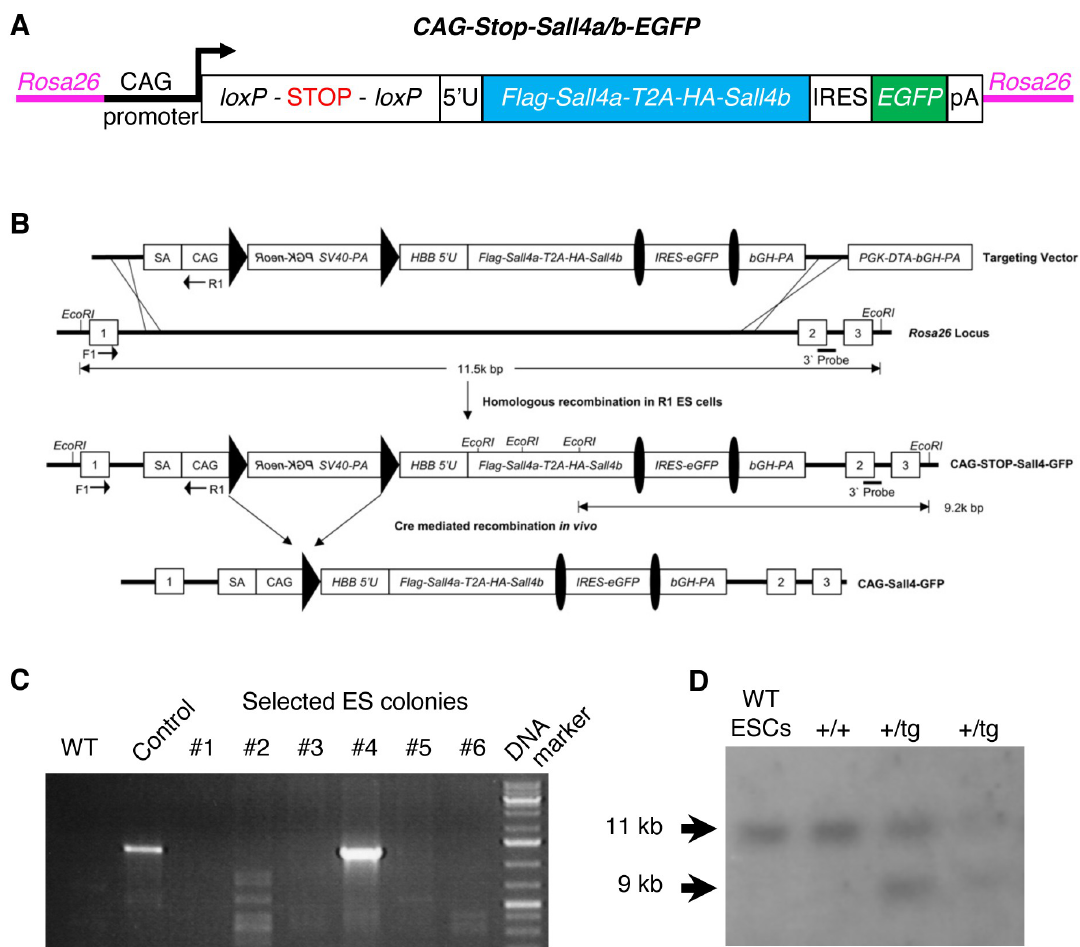
Fig 1. Sall4 conditional expression transgene. (A) Targeting vector used to insert the conditional expression construct for Sall4 into the Rosa26 locus in ES cells. (B) Schematic of the targeting strategy. The targeting vector also contains a diphtheria toxin negative selection cassette ( PGK-DTA-bGH-PA ) with diphtheria toxin expressed from the PGK promoter and followed by a bovine growth hormone poly-adenylation site. Homologous recombination into the Rosa26 locus removed PGK-DTA-bGH-PA and produced the single copy transgene CAG-Stop- Sall4-IRES-EGFP . Cre-mediated recombination deletes the “floxed” stop cassette to generate CAG-Sall4-IRES-EGFP . (C) Correct homologous recombination of the 5’ homology arm of the targeting vector into Rosa26 was confirmed by PCR of ES cell genomic DNA using primers F1 and R1 (indicated in panel B), which amplify between exon 1 of Rosa26 and the CAG promoter. No amplification product was detected in wild-type ES cells, but the predicted 1248 bp amplicon was detected in a targeted ES cell clone (#4). Control DNA was prepared from the tail clip of conditional Dmrt1 expression mouse that was generated using the same knockin system (33). (D) Homologous recombination of the 3’ vector arm was confirmed by Southern blotting using the 3’ probe indicated in panel B. Wild-type ES cell DNA generated in detection of the predicted 11 kb fragment, whereas targeted clones (two right lanes) generated both the 11 kb fragment and a 9 kb fragment corresponding to the targeted allele.